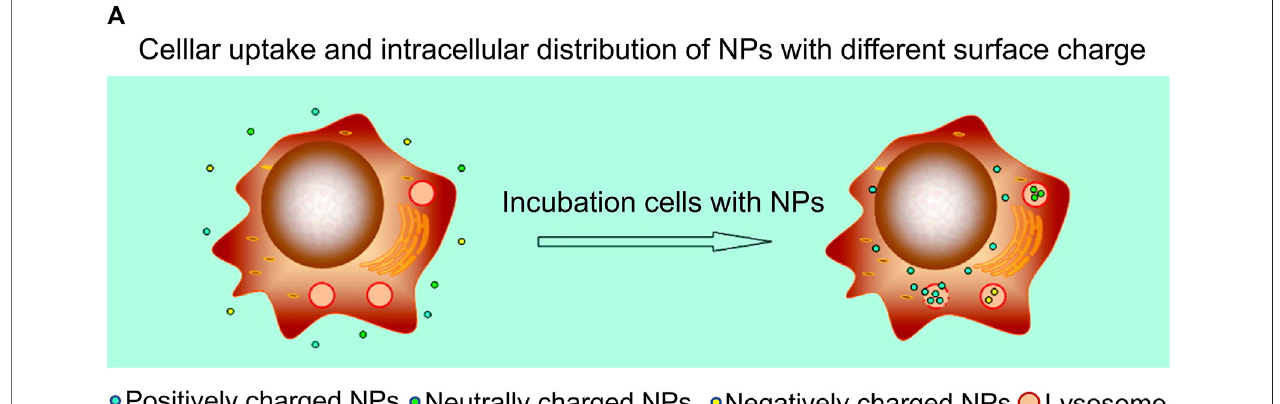
Frontiers in Pharmacology |